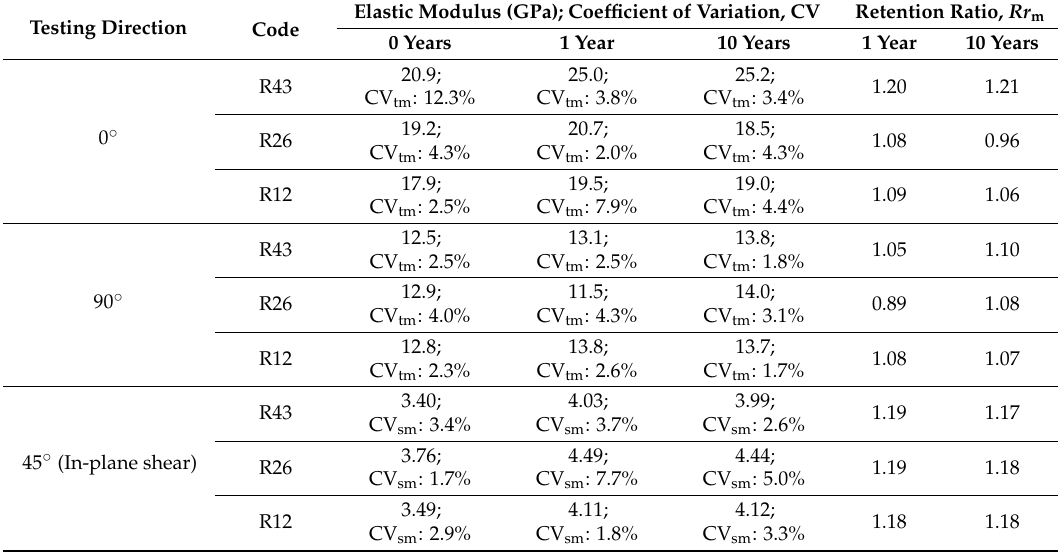
Table 8. Elastic modulus of painted specimens with retention